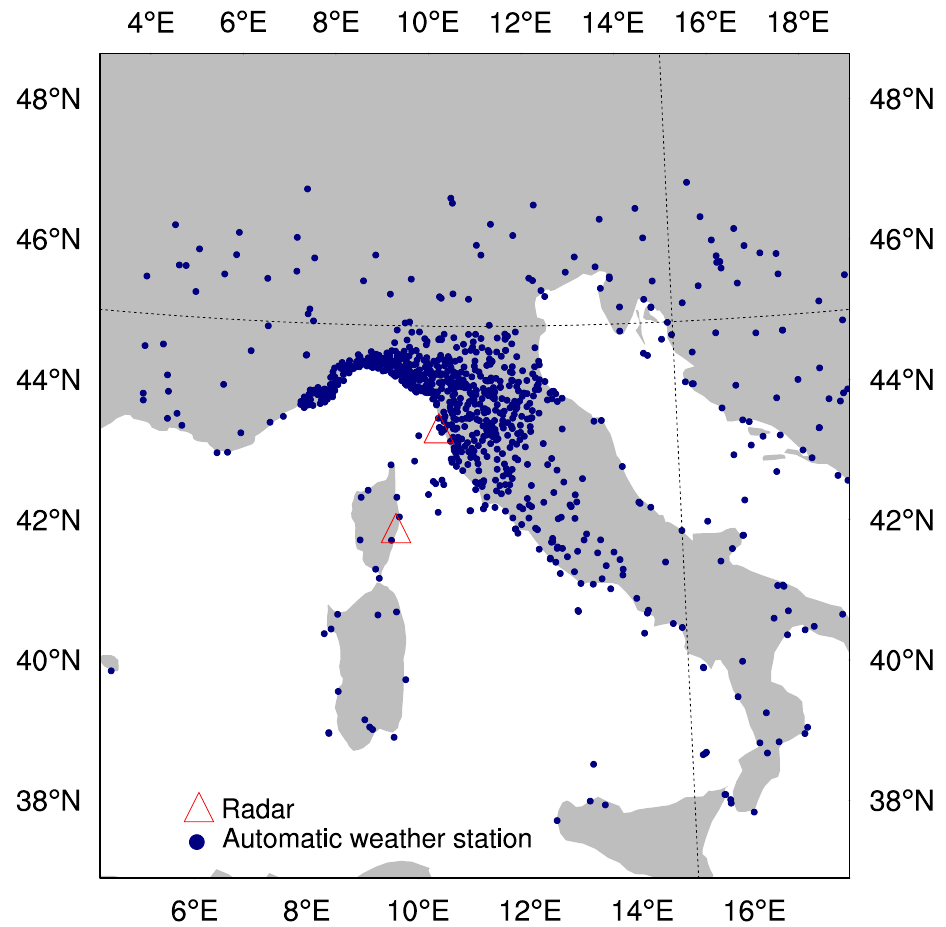
Figure 5. Geographical extent of the domain of integration of the WRF model. The two red triangles “ (cid:52) ” indicate the locations of the Aléria (in the Corsica region) and Livorno (on the Tyrrhenian coast) radar stations. The blue dots indicate the locations of the ground weather stations assimilated during the assimilation